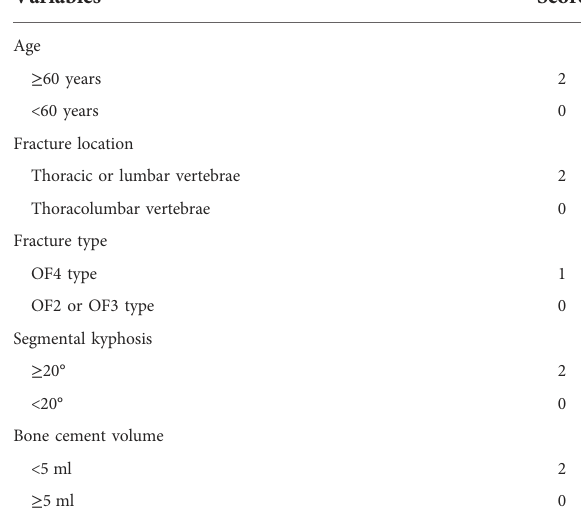
TABLE 3 The scoring system for predicting residual back pain after